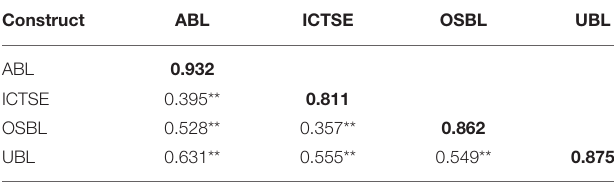
TABLE 4 | Discriminant validity for the measurement model.